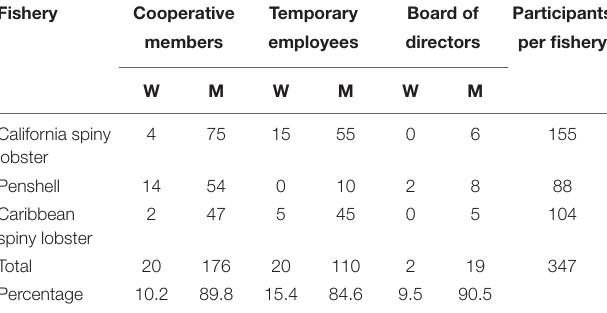
TABLE 3 | Participation of women (W) and men (M) as cooperative members, temporary employees, and members of the board of directors in the fishing